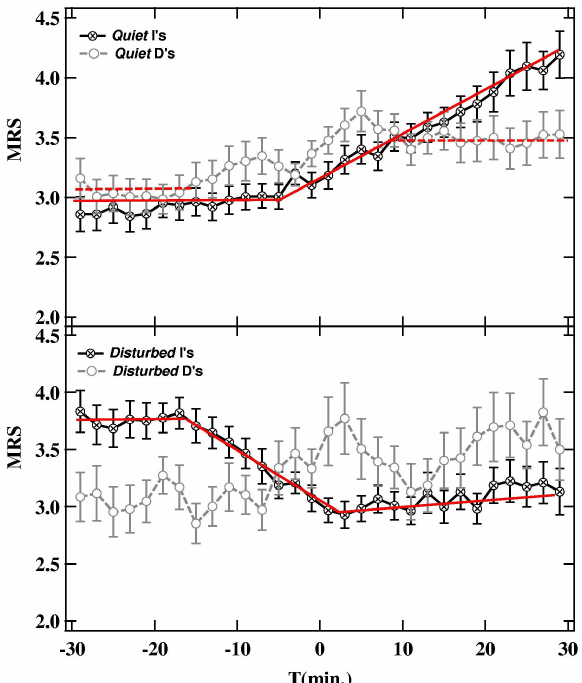
Fig. 6. Upper panel: plot of MRS vs. time for Increases (black curve) and Decreases (grey curve) for Quiet events (60I, 29D). Lower panel: the same as for the upper panel, but for Disturbed events (48I,